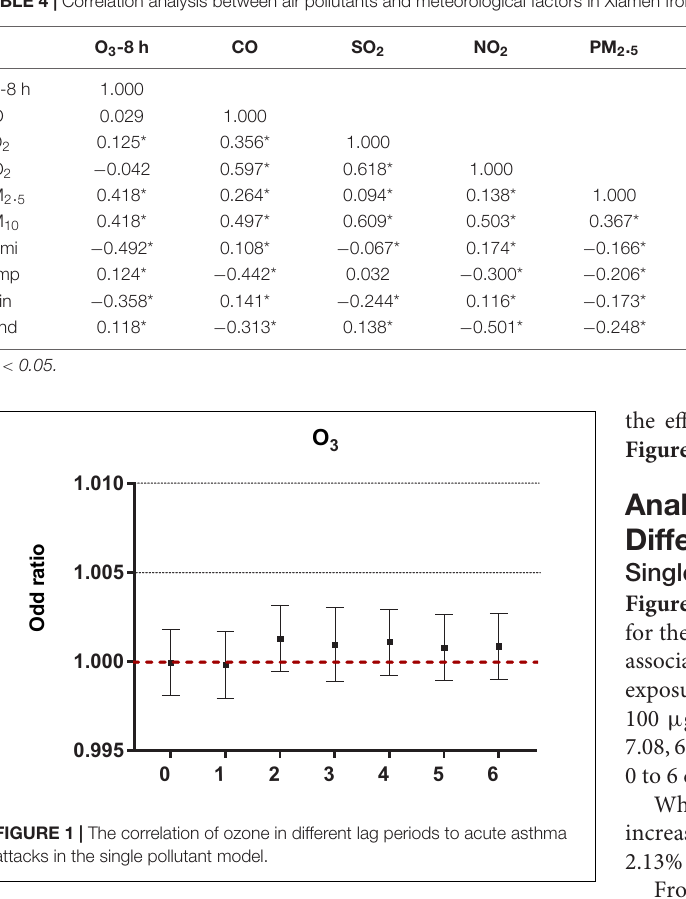
After controlling the confounding factors of daily relative the single pollutant models were established, as shown in Figure 1